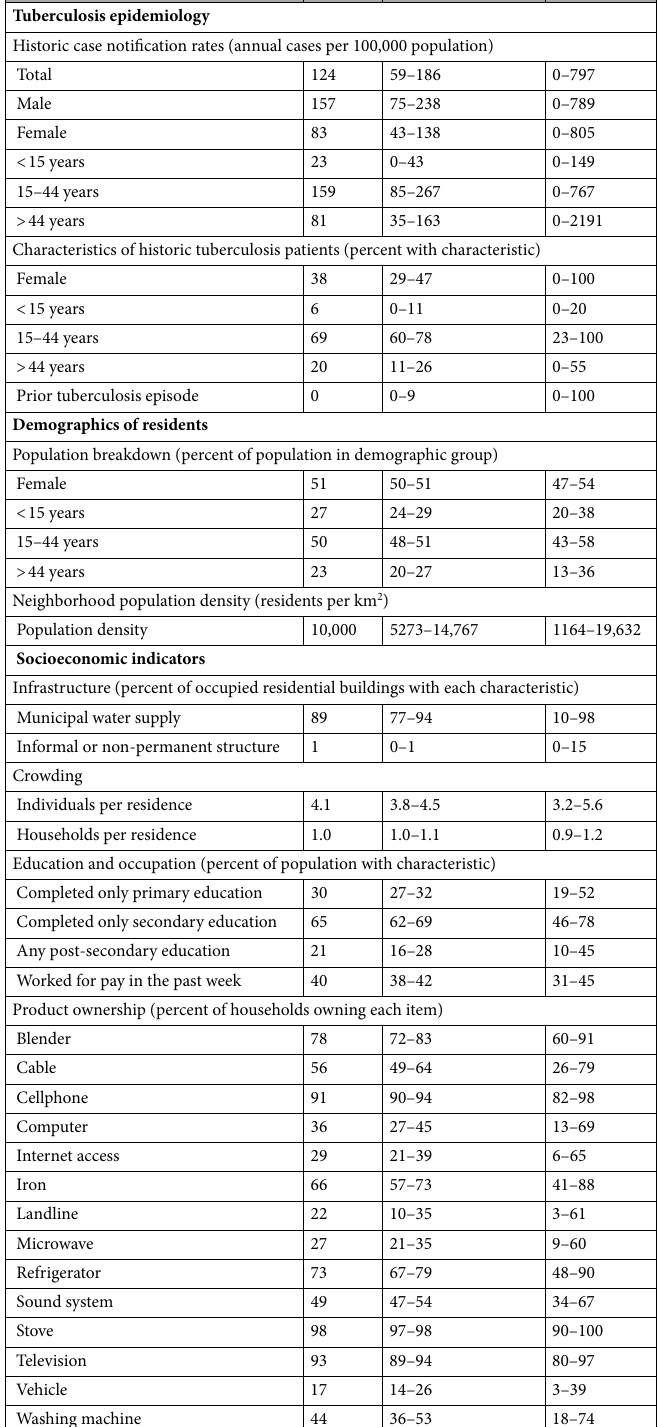
Table 1. Neighborhood epidemiologic, demographic, and socioeconomic characteristics ( n = 74